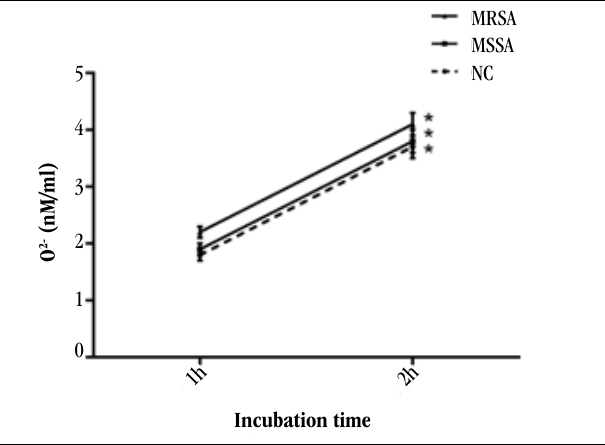
24 h figurE 3 – Kinetics of O 2- production by alveolar macrophages from adult Wistar rats for